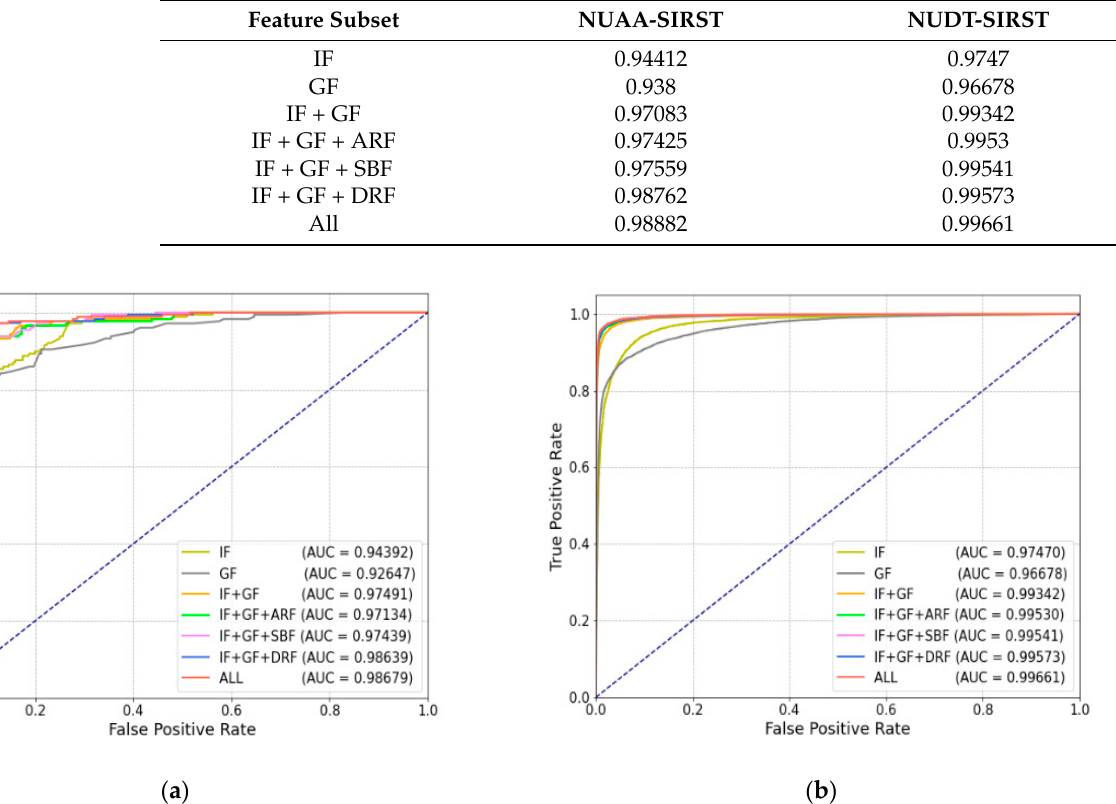
Figure 7. ROC curve of candidate classification with different features on two datasets: ( a ) results on NUAA-SIRST, and ( b ) results on NUDT-SIRST.